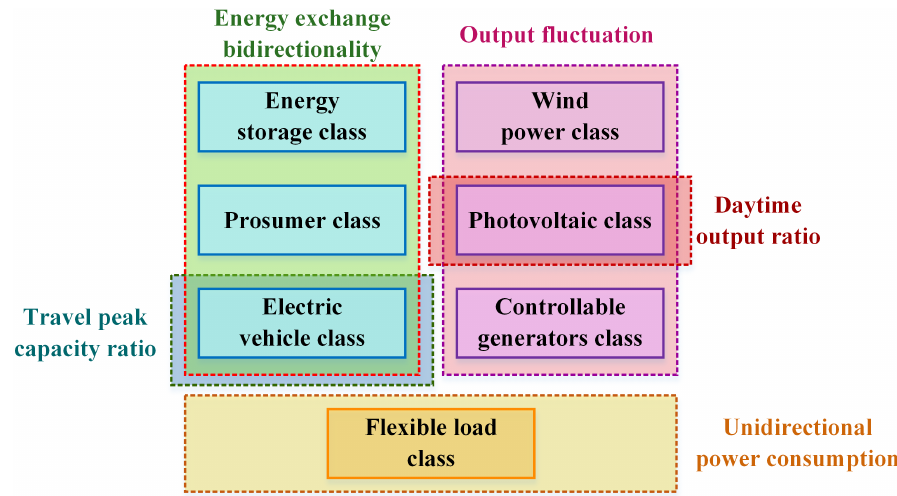
Figure 2. Summary of the clustering index for the various distributed units.